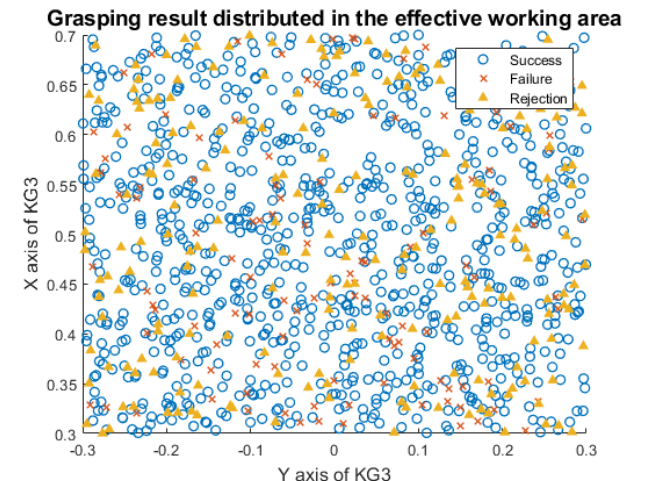
Figure 7. The curve of the fitted quadratic function when changing the number of point cloud slices at the furthest effective working distance ( d is equal to 0.7 m). ( a ) Fitted quadratic function of real object; ( b ) fitted quadratic function of object photo.